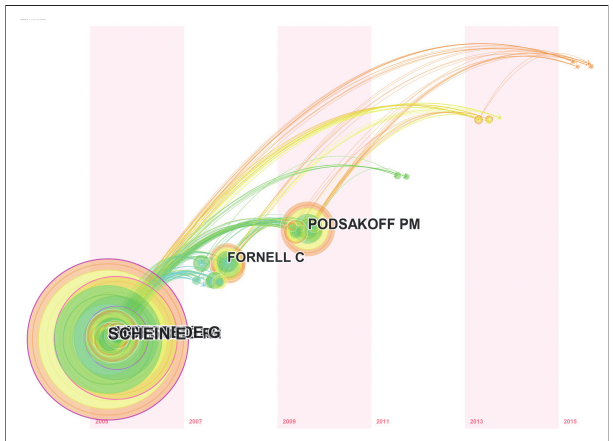
FIGURE 12: Map of reference authors: Timezone